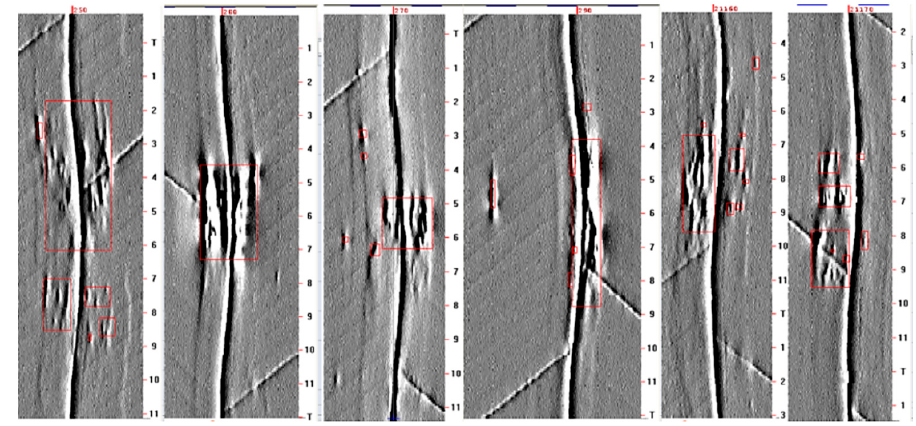
Figure 10. Typical MFL gray-scale signals for FJC failure corrosion.